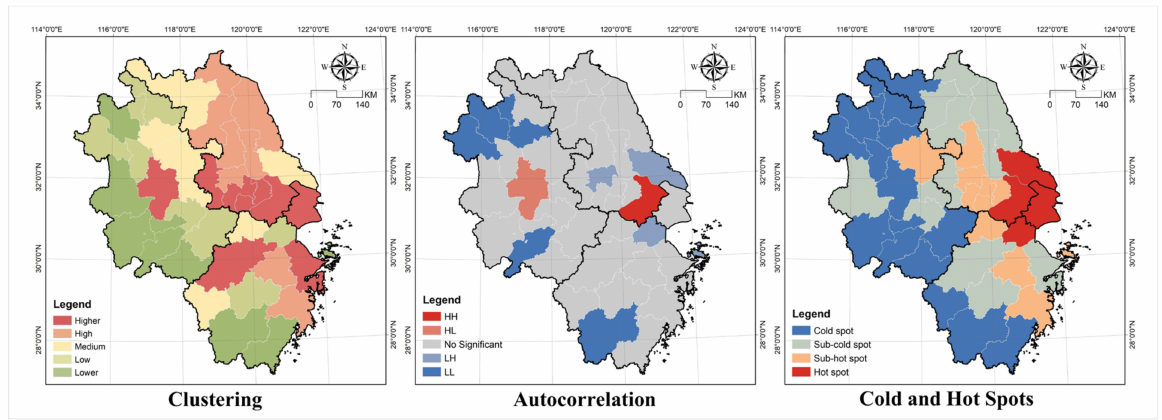
Figure 5. Spatial analysis of the relative share in